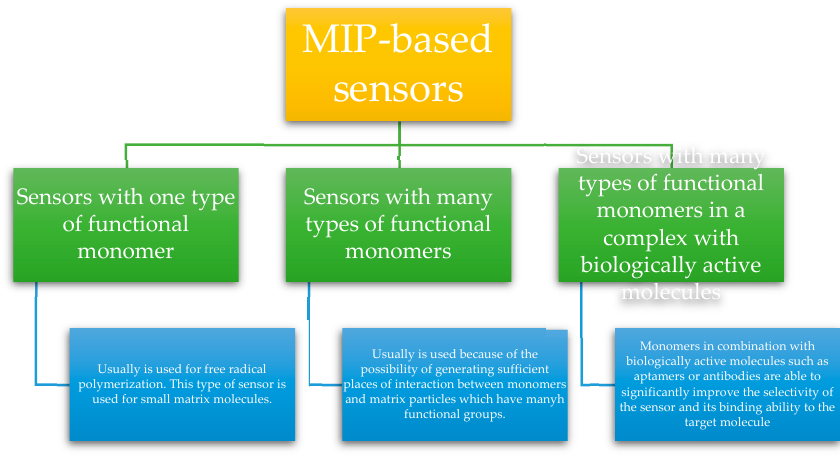
Figure 10. Three basic types of MIP-based sensors.